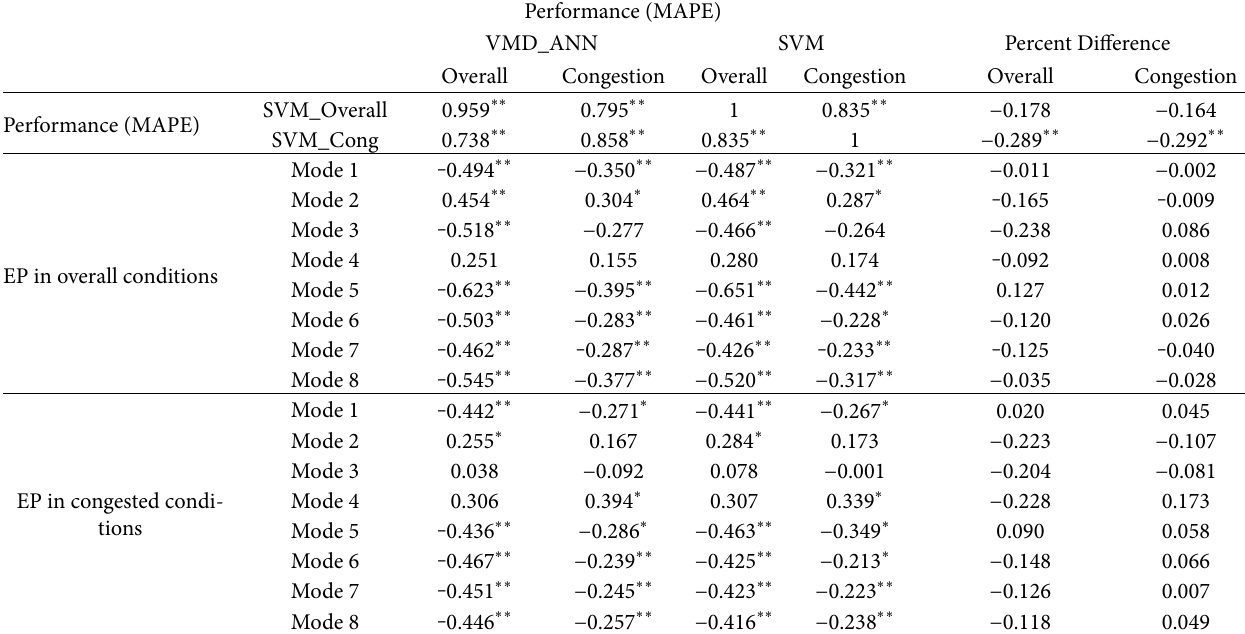
Table 3: Results of correlation analysis for properties of modes and predicted